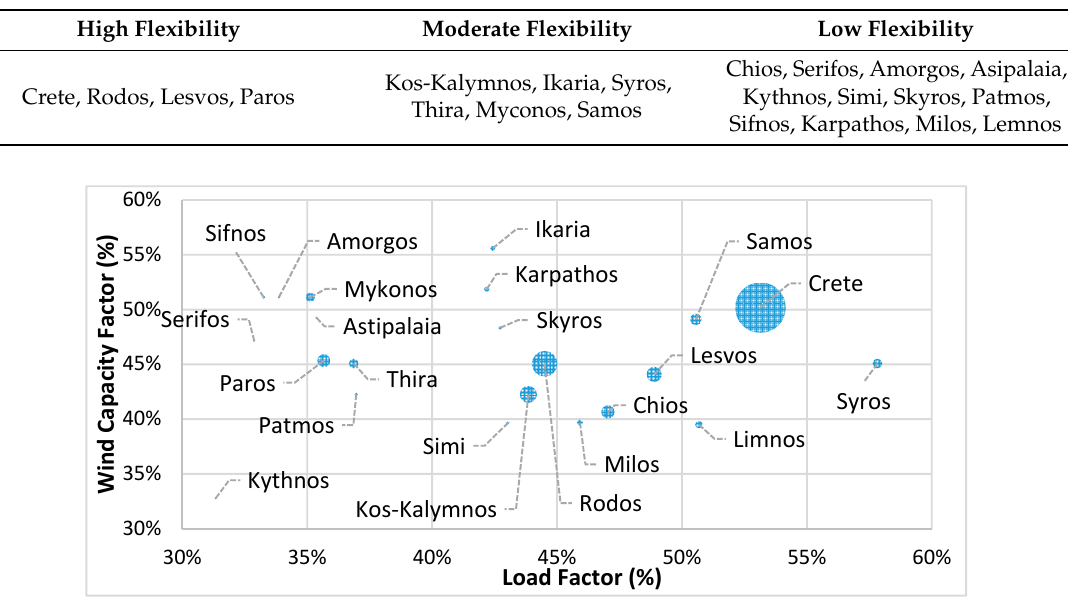
Table 4. Ranking of islands in terms of power system’s flexibility.